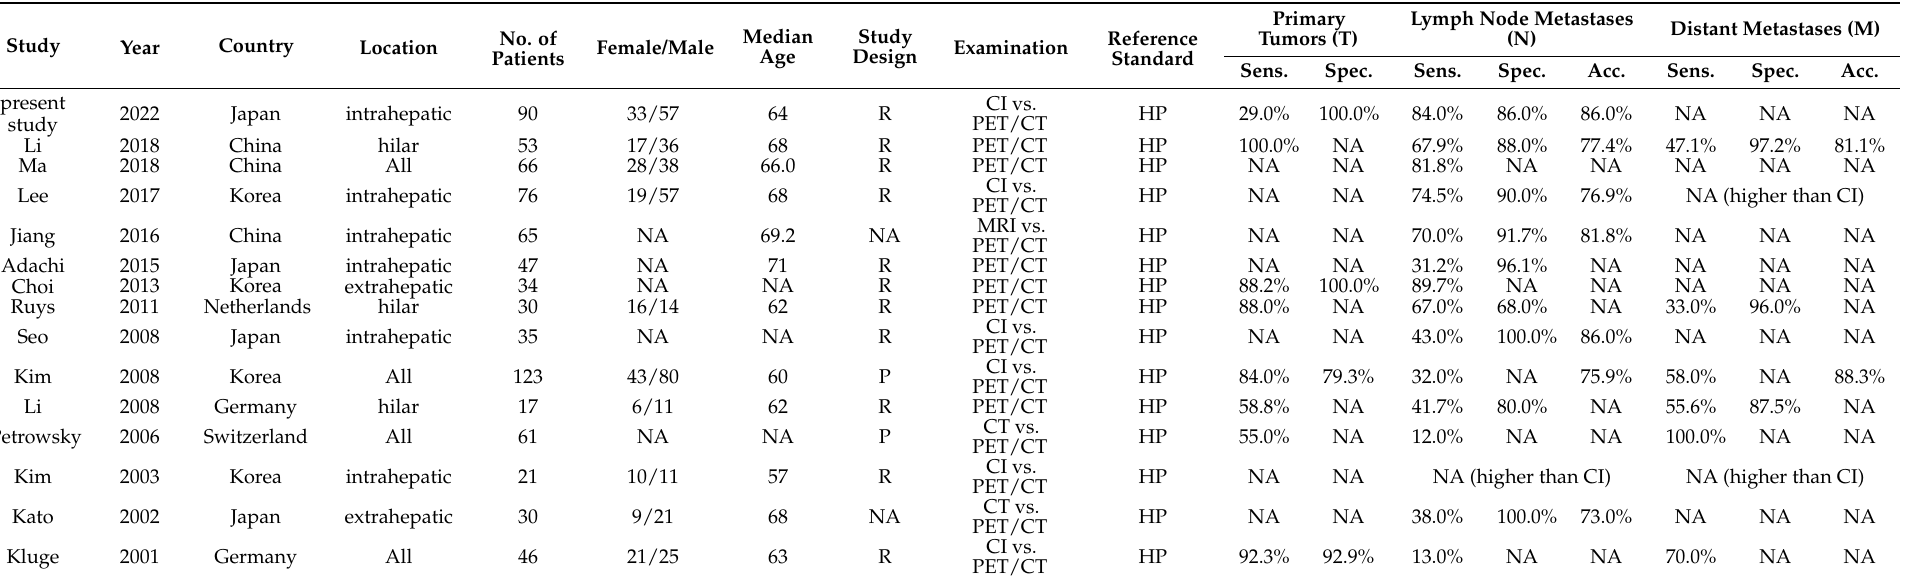
Table 5. The principal characteristics and diagnostic performances on PET-CT of past